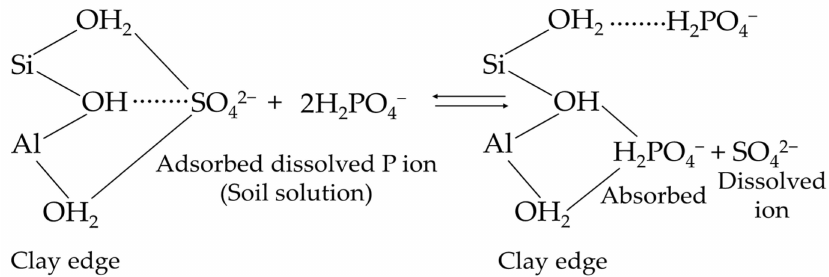
Figure 3. Anion exchange reaction in the phosphorus fixation process